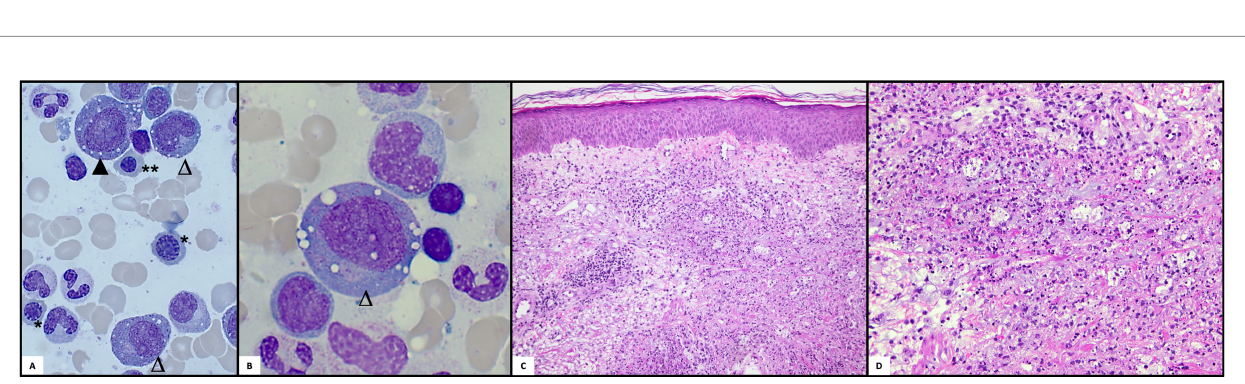
FIGURE 3 | Cutaneous manifestations. (A) Pustulosis of the left arm. (B) Abdominal panniculitis after local application of anakinra. (C) Cervico-thoracic neutrophilic dermatosis. (D) Close up picture of cervico-thoracic neutrophilic dermatosis in (C) . (E) Nodular phlebitis of the right